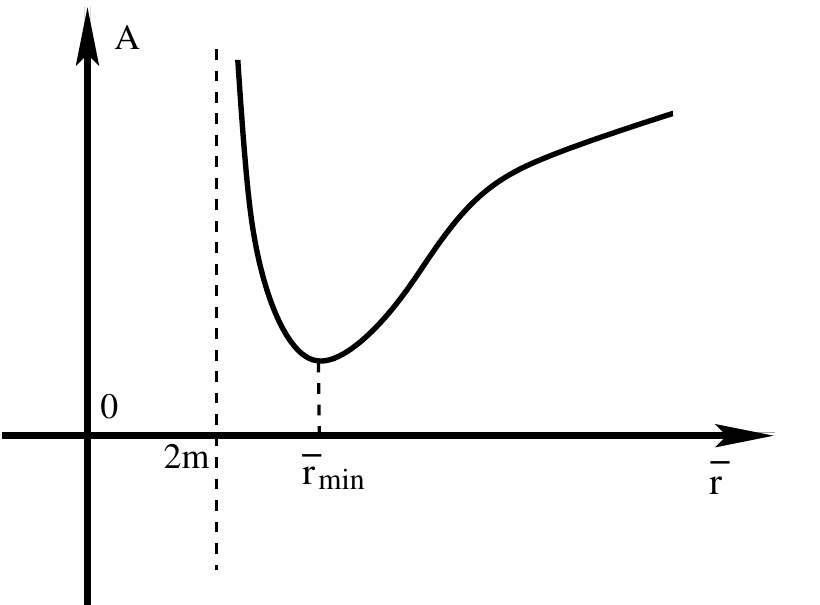
Figure 1. The geometric area A of the 2-dimensional spheres t , ¯ r = Constant vs the radial coordinate ¯ r for the spacetime described by the metric (49) with c 14 (cid:54) = 0, where A is given by Equation (53). The point ¯ r = ¯ r min defined by Equations (48) and (54) is the minimal surface for the area A —the throat. The area A becomes infinitely large at both ¯ r = 2 m and ¯ r = ∞ , and the spacetime is singular at ¯ r = 2 m , but asymptotically flat as ¯ r → ∞